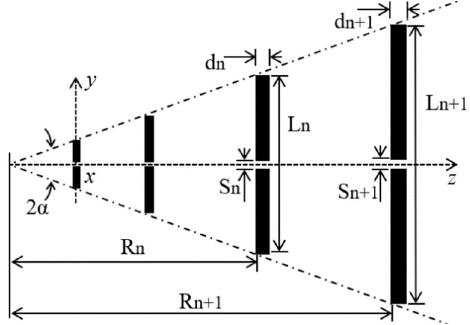
Figure 2. Classical geometry of a wire log-periodic antenna.